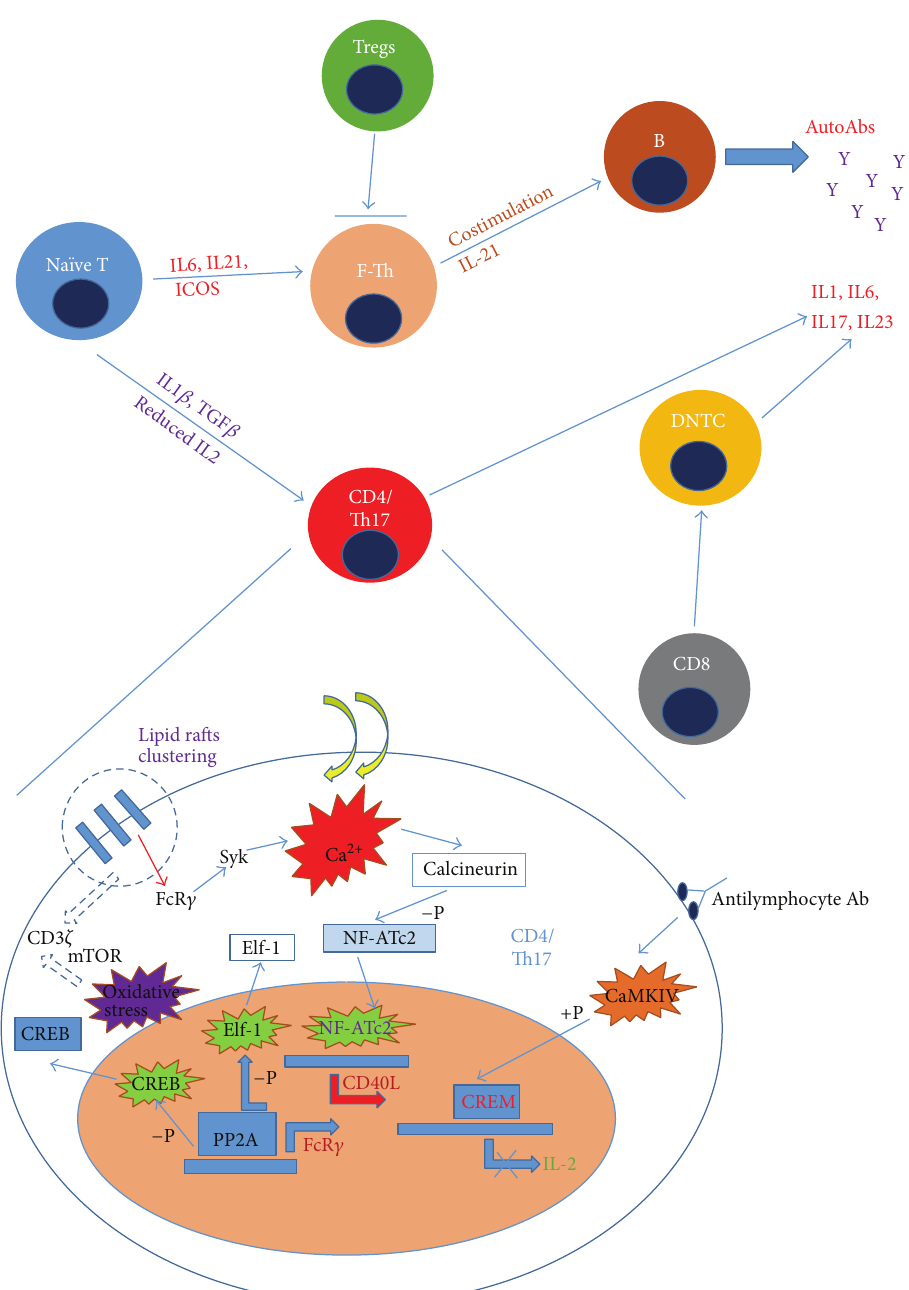
Figure 1: Development of lupus T cells, their interactions with T-regulatory cells and B cells, and alterations of the intracellular physiology of effector lupus T cells. Na¨ıve T cells develop into follicular T-helper cells which cross-talk with B cells for autoantibody production under the stimulation of IL6, IL-21, and ICOS. Na¨ıve T cells develop into effector CD4+ and Th17+ T cells which produce proinflammatory cytokines and exhibit altered intracellular physiology including clustering of CD3-TCR, oxidative-stress induced calcium flux, and consequent change in mRNA transcriptions of various important genes (see text for details). Abbreviations: Tregs, regulatory T cells; ICOS, inducible T-cell costimulator; F-Th, follicular T-helper cells; Syk, spleen tyrosine kinase; CaMKIV, calcium/calmodulin-dependent kinase IV; CREB/CREM, cAMP response element (CRE) binding protein (CREB)/CRE-modulator (CREM); NF-ATc2, nuclear factor of activated T cells; Elf-1, transcriptionfactorElf-1;Ca 2+ ,calciumion;PP2A,proteinphosphatase2A;mTOR,mitochondrialtransmembranepotentialandmammalian target of rapamycin; +P, phosphorylation; − P,